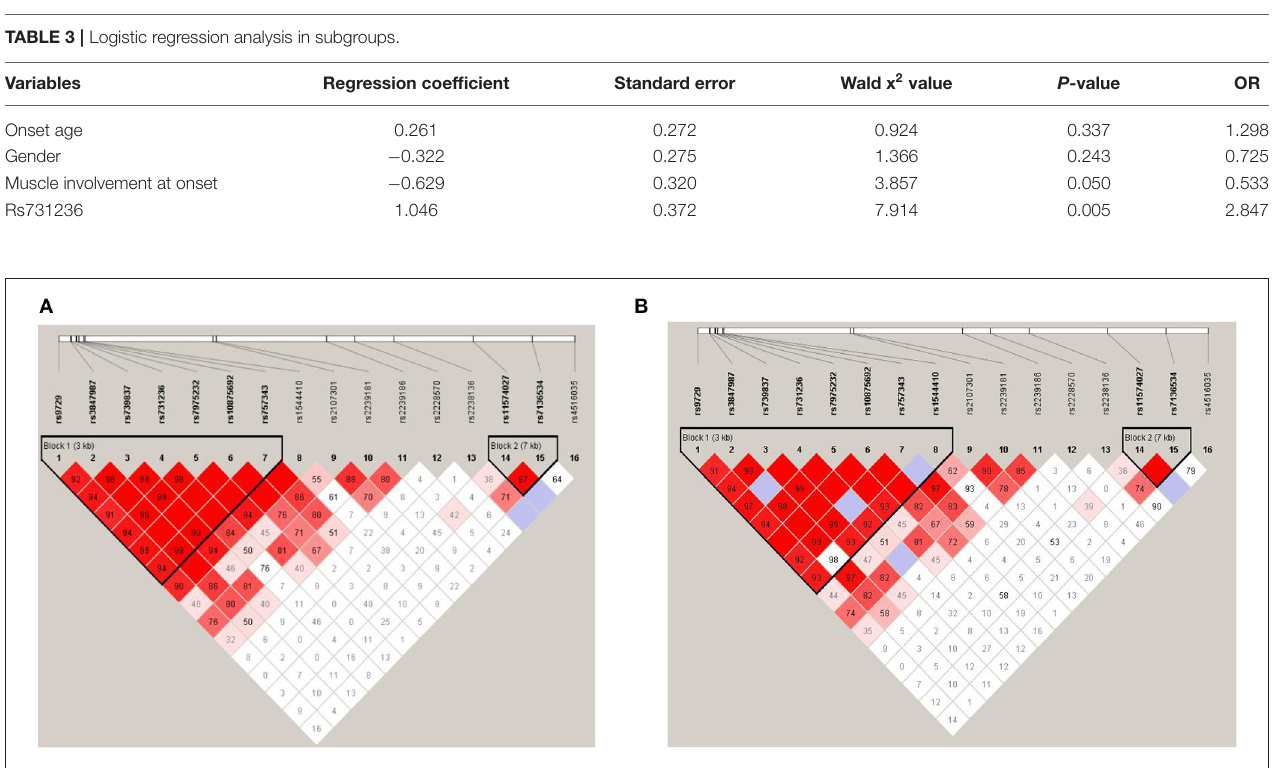
FIGURE 2 | Linkage disequilibrium (LD) plot and haplotype block construction. MG patients and healthy controls (A) ; adult non-thymoma AChRAb negative MG patients and healthy controls (B) . The locations of each SNP were indicated by the straight lines. The D’ value corresponding to each SNP pair was expressed as a percentage and shown within the respective square (D’ = 1, not shown). Higher D’ values were indicated in darker